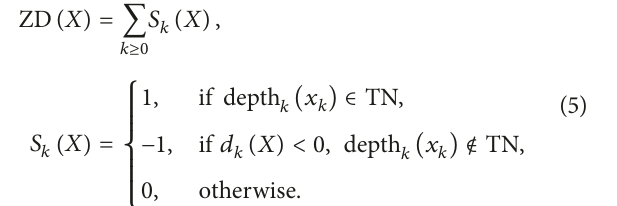
Table 1: The behaviors of different statistics confronted with differ- ent cases; the symbols √ , 󳵻 , × , and R indicate high, medium, low, and random values, respectively. Total ZD SDFV